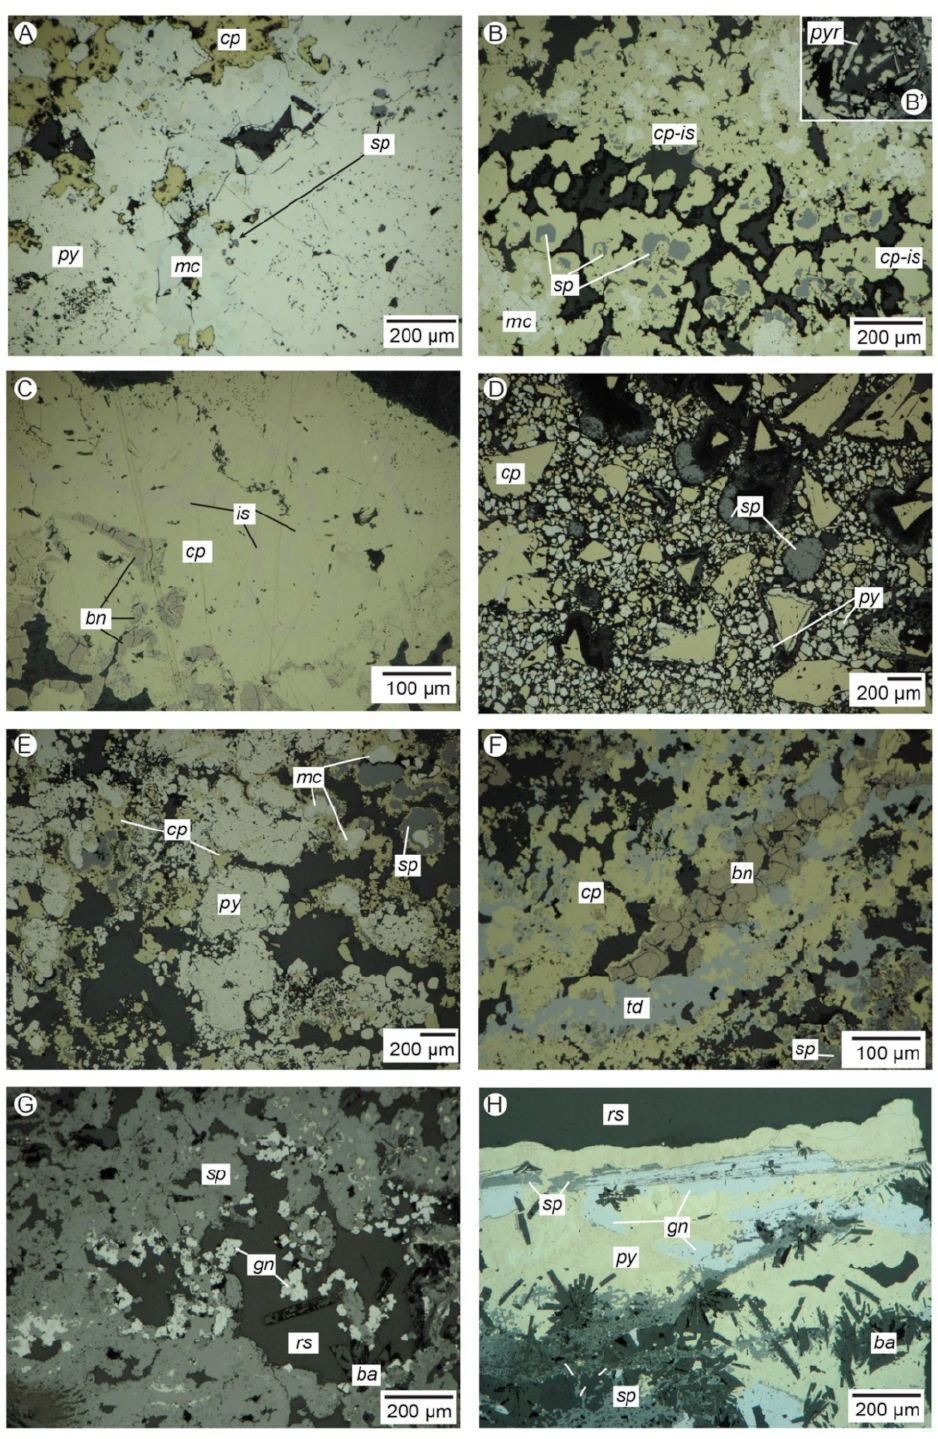
Figure 2. Reflected light photographs highlighting the range of seafloor sulfide minerals and common textures observed and analysed throughout this study. ( A ) Massive and porous textures of pyrite (py; porous—bottom left), euhedral marcasite (mc) with massive chalcopyrite (cp) and sphalerite (sp) inclusions from TAG, MAR (TAG-46); ( B ) Active sample from Turtle Pits, MAR (TP4B) showing early marcasite overgrown by chalcopyrite-isocubanite (cp-is) and sphalerite with colloform textures, ( B’ ) Pyrrhotite (pyr) laths; ( C ) Active chimney talus from Logatchev, MAR (LOG-11) demonstrating patchy distribution of elongated isocubanite (is) exsolved within massive chalcopyrite and bornite (bn) forming along fractures and around grain boundaries of chalcopyrite; ( D ) Sample taken from an inactive chimney at the 16 ◦ 43’S hydrothermal field along the East Pacific Rise (SEPR) showing